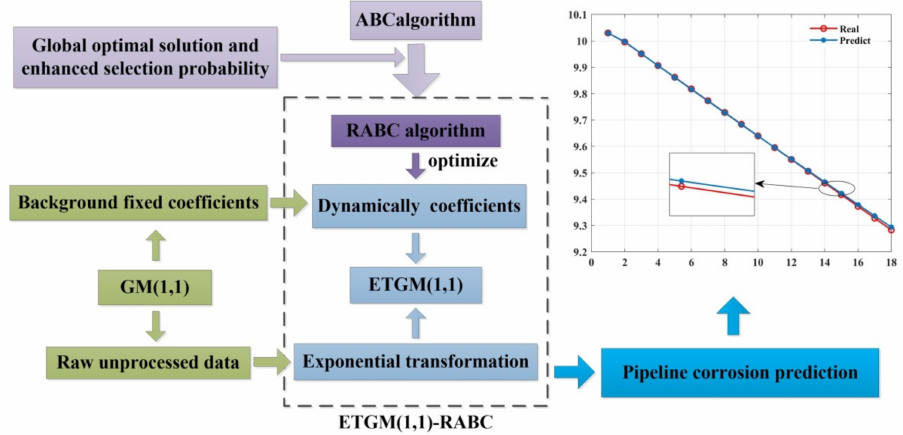
Figure 2. The schematic of the proposed